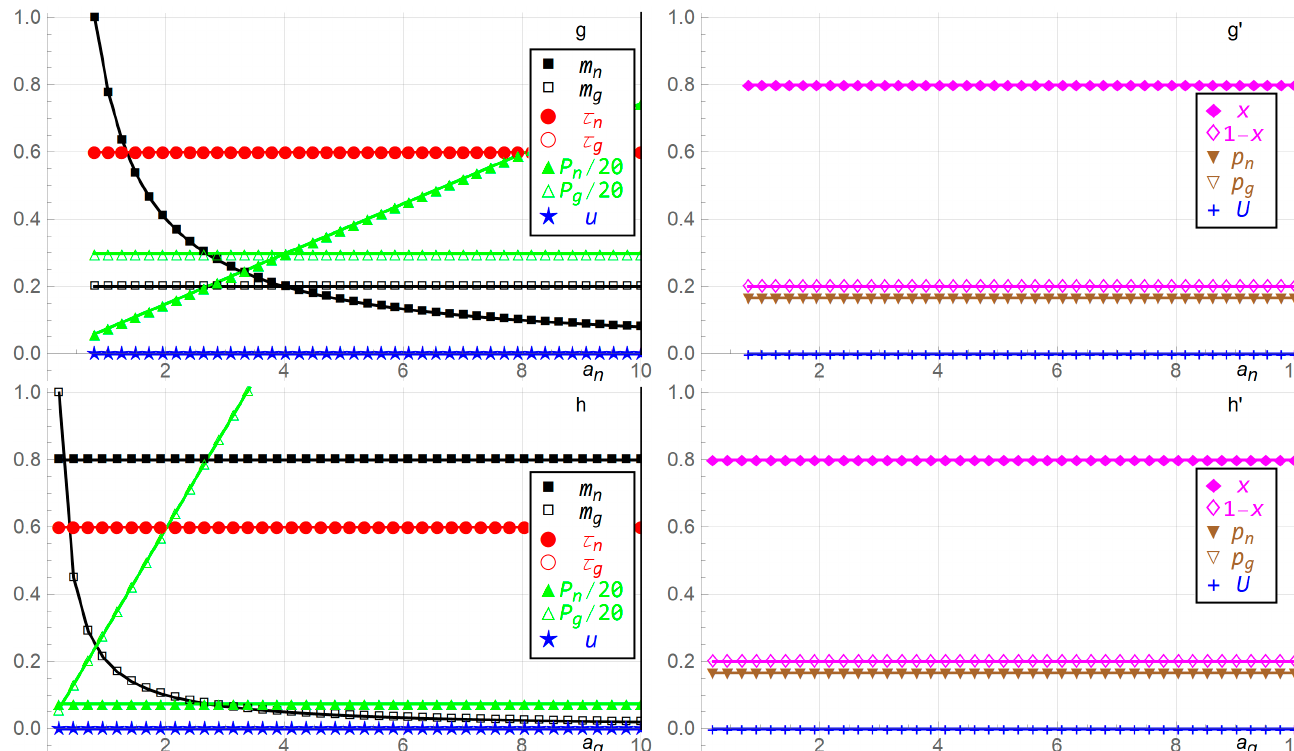
Figure 4. The government’s monitoring probability m j , taxation τ j , penalty factor P j , and expected utility u , and the household’s fractions x and 1 − x of currencies n and g , probability p j of tax evasion on currency j , and expected utility U , as functions of the eight parameter values α , λ n , λ g , β n , γ n , β g , a n , a g relative to the benchmark parameter values α = 4/5, λ n = λ g = 1/5, β n = γ n = 2/5, β g = 1/10, a n = a g = 1. The eight double panels, for the eight parameters α , λ n , λ g , β n , γ n , β g , a n , a g , are referred to as ( a , a (cid:48) ); ( b , b (cid:48) ); ( c , c (cid:48) ); ( d , d (cid:48) ); ( e , e (cid:48) ); ( f , f (cid:48) ); ( g , g (cid:48) ); and ( h , h (cid:48) ). Division of P j with 20 is for scaling purposes, j = n , g